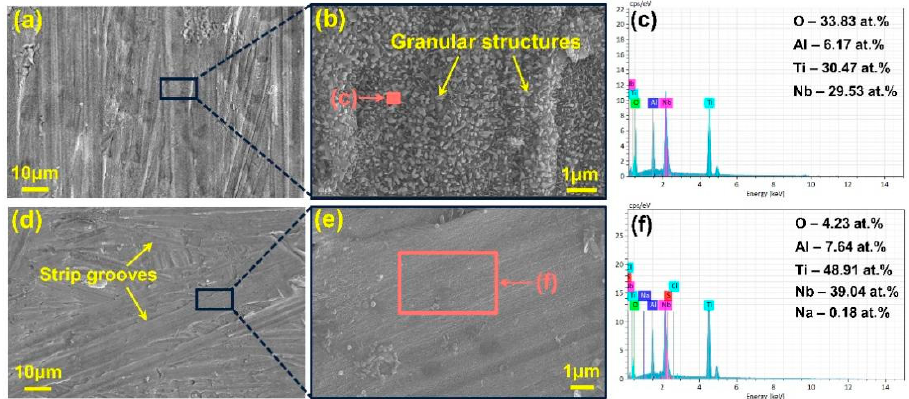
Figure 5. Surface SEM images and EDS spectra of the samples: ( a – c ) High temperature oxidation test; ( d – f ) Salt spray test.